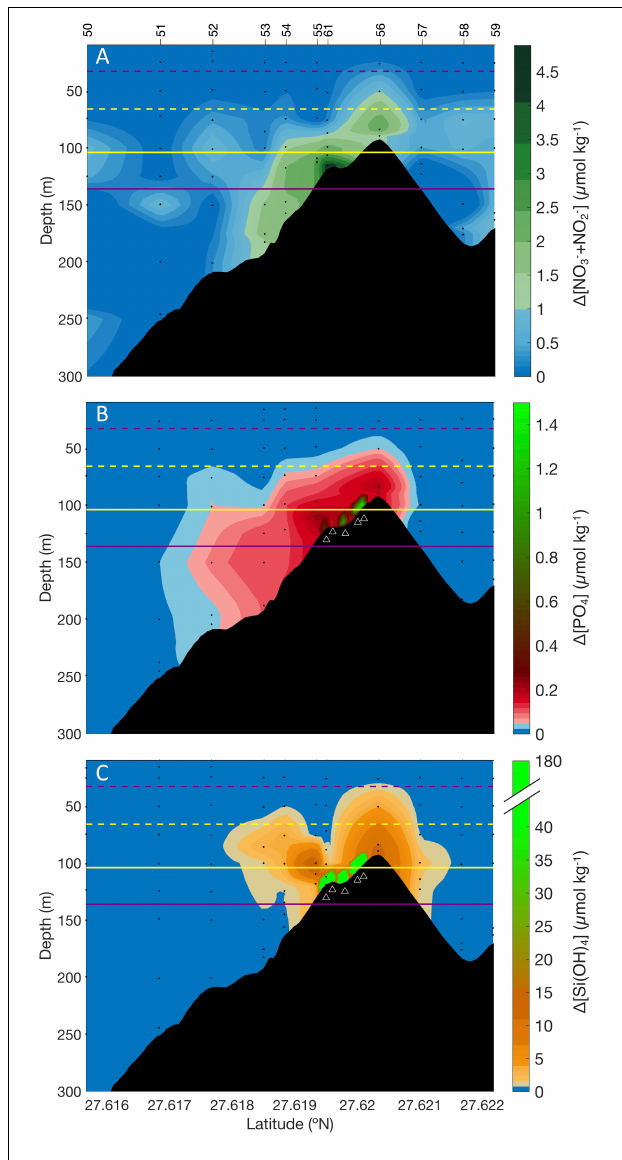
FIGURE 5 | Vertical contours of anomalies of (A) nitrate, (B) phosphate, and (C) silicate in a high-resolution transect of the main cone during the degassing stage. The blue tones show anomalies within the standard deviation of the reference (non-significant anomalies). Stations that presented maximum anomalies from cruises 7–9 were selected for the contours. Data collected in cruise 15 from several vents (marked as triangles) are also shown in panels (B,C) . Horizontal lines show the depth of the mixed layer (purple) and of the euphotic zone (yellow), as minimum and maximum values (dashed lines and solid lines, respectively) obtained from monthly averaged datasets provided by the Copernicus Marine Environment Monitoring Service (see Data and